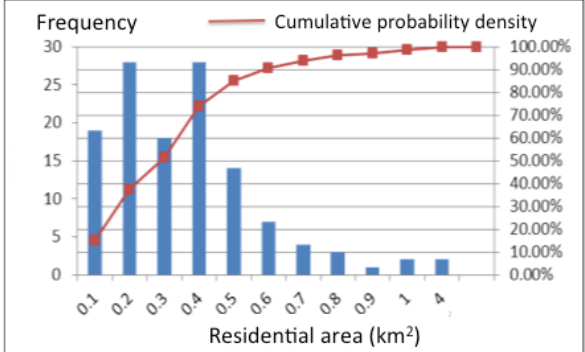
Figure 4. Probability density distribution of village